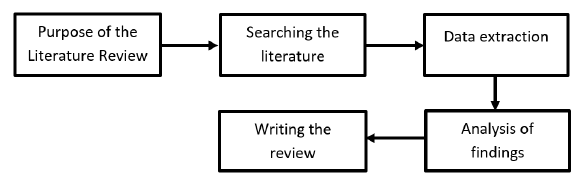
Figure 1: Systemic Literature Review flowchart